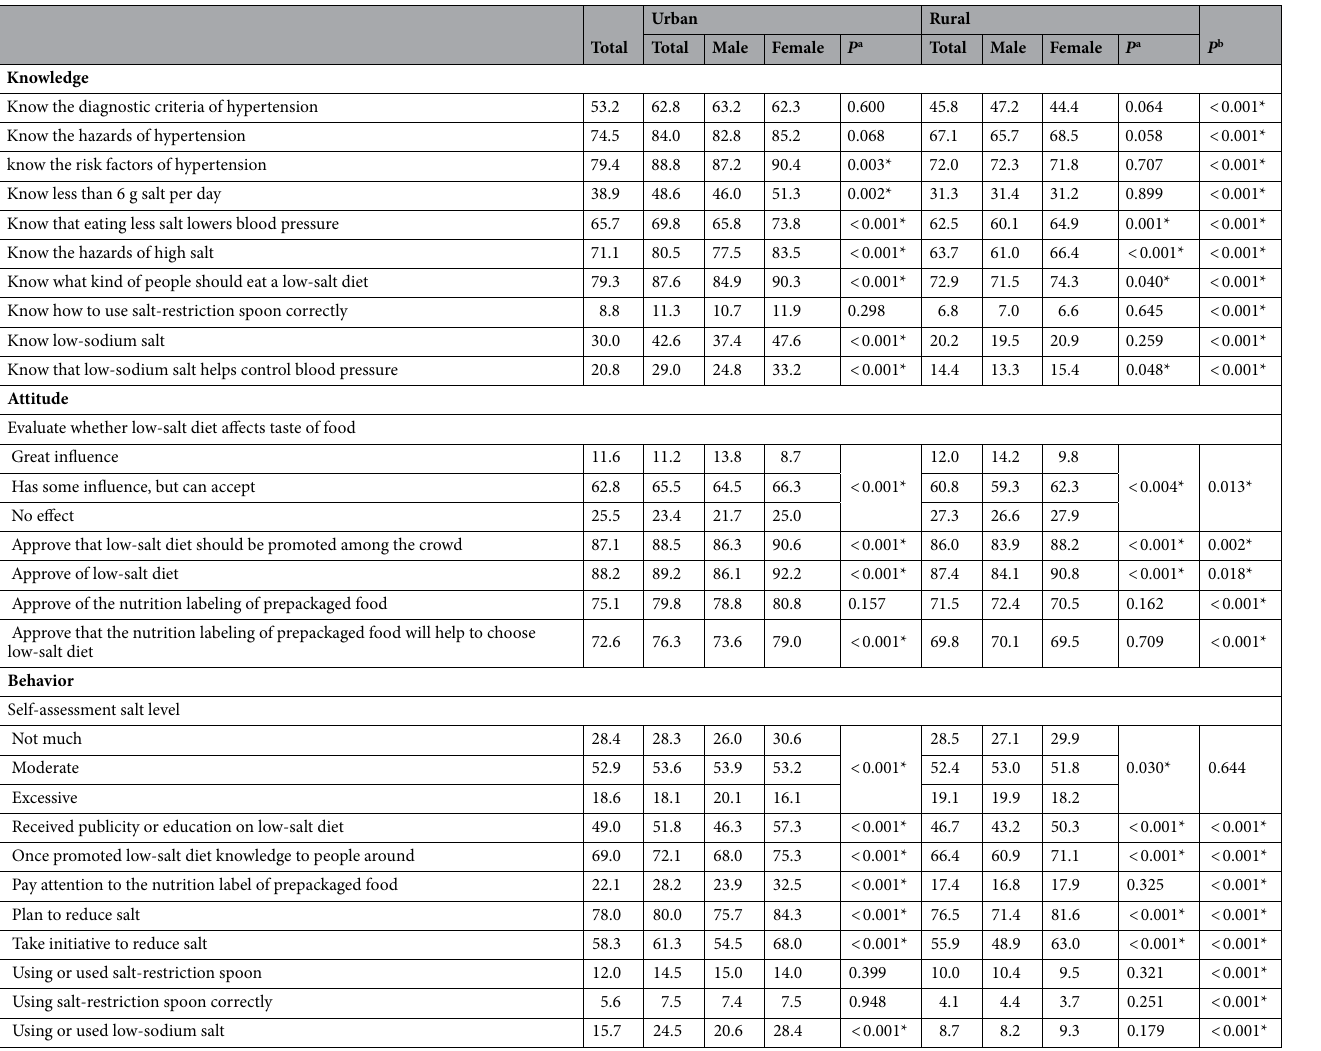
Table 2. Knowledge, attitudes, and behaviors related to salt among Zhejiang residents, SRHPP 2017–2018: %. a Significant difference between male and female in the KAB rates. b Significant difference between urban